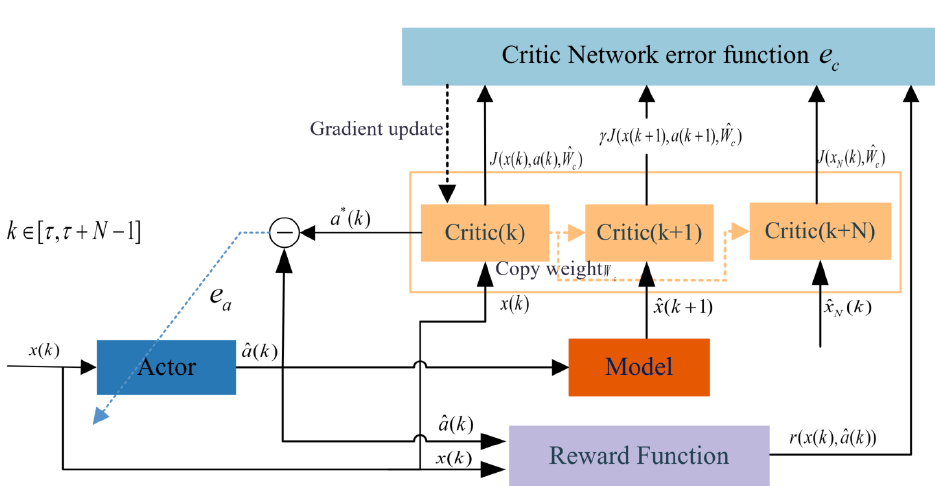
Figure 2. The structure of the finite horizon reinforcement